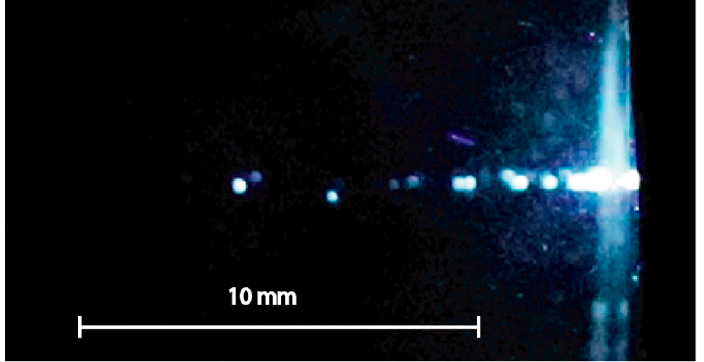
Figure 10. A video frame of the optical breakdown in transparent KU-1 glass at a pulse energy E L ≈